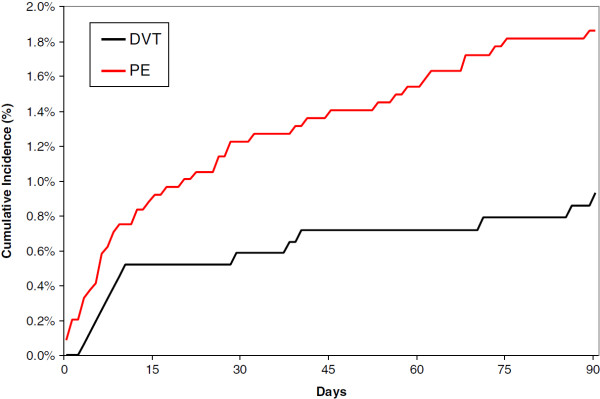
PE recurrences according to initial presentation as DVT or PE.